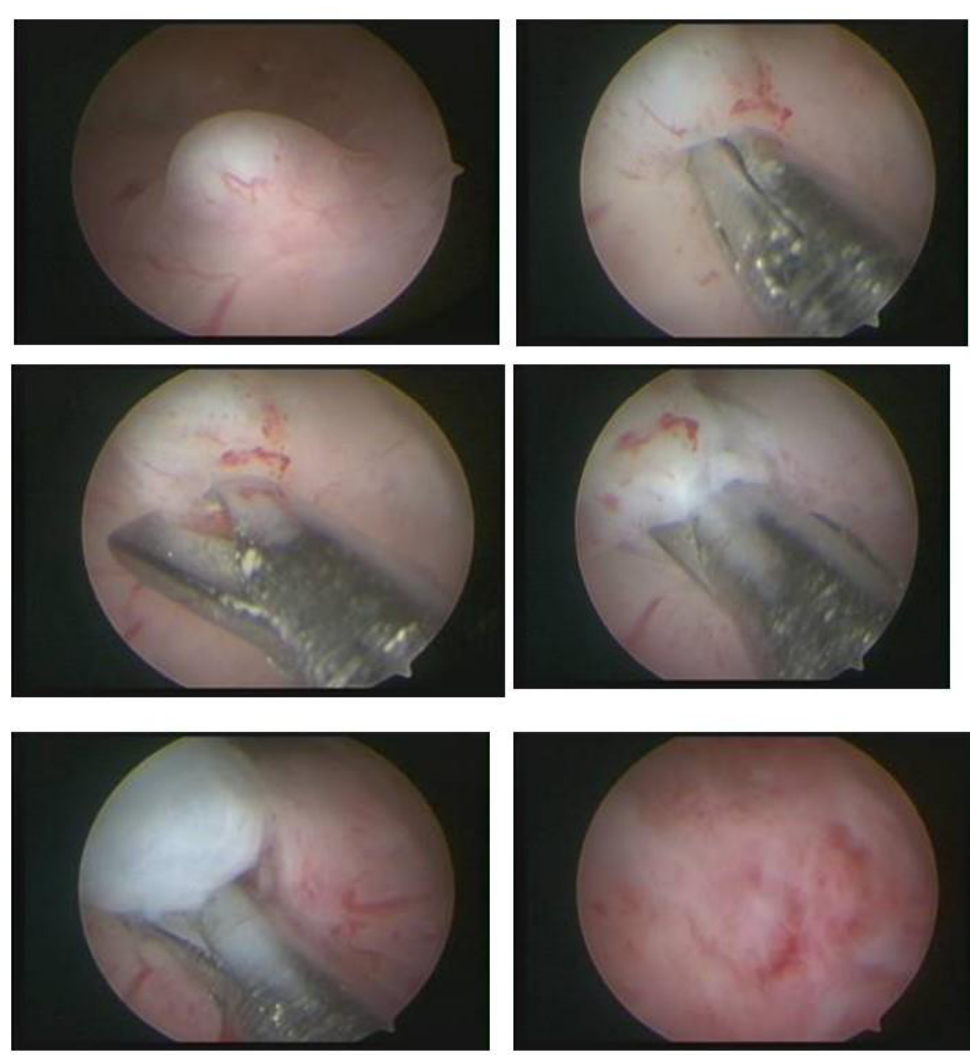
Figure 7. Office hystreroscopic myomectomy with scissor.